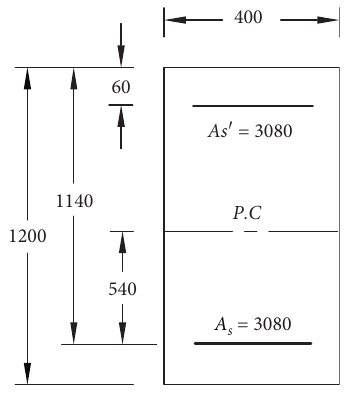
Figure 9: Column CB-7 ( X - X axis).